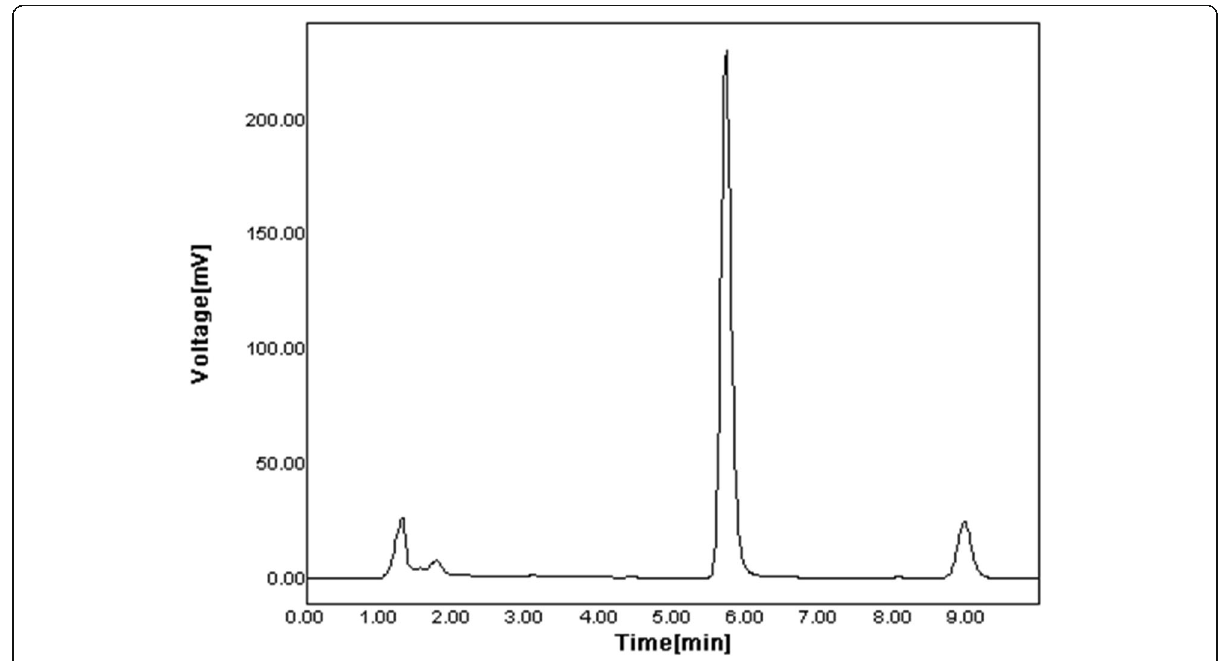
Fig. 4 Chromatogram of clotrimazole gelatin